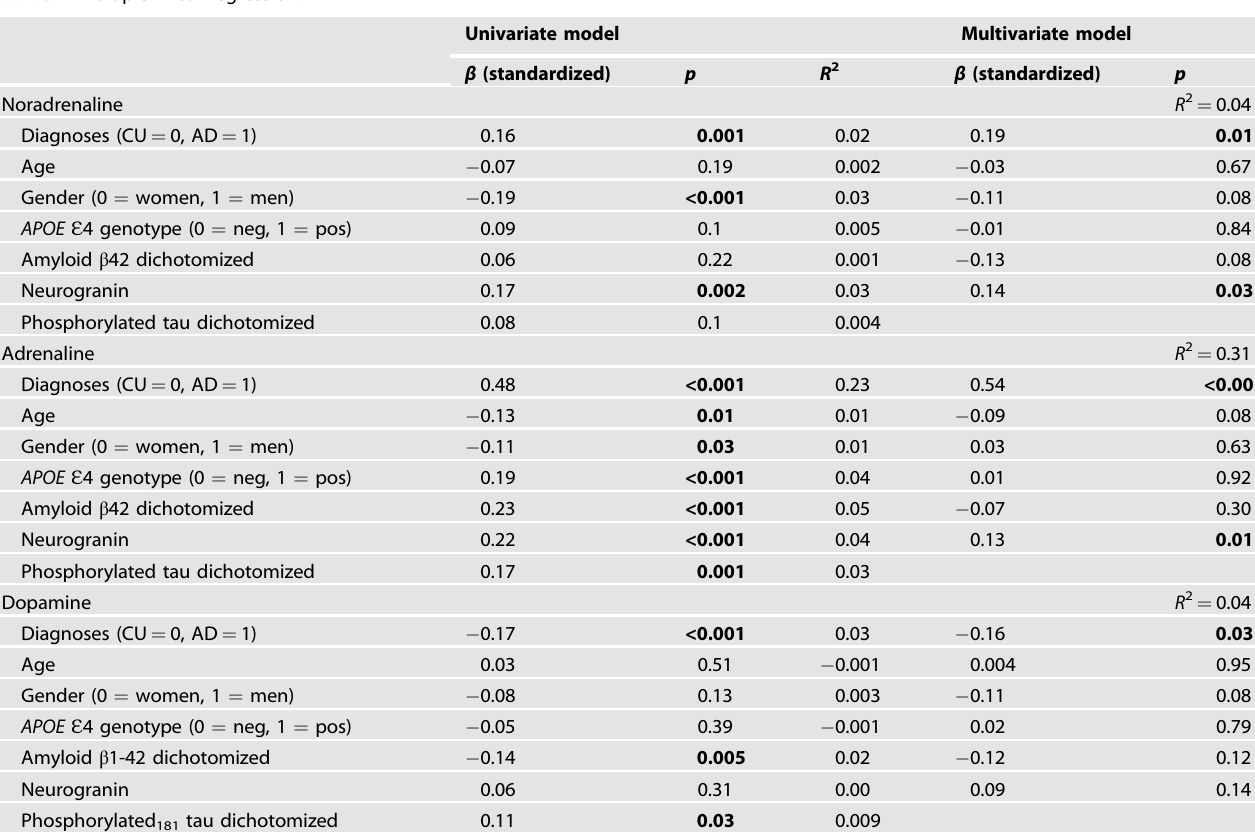
Table 3. Multiple linear regression.